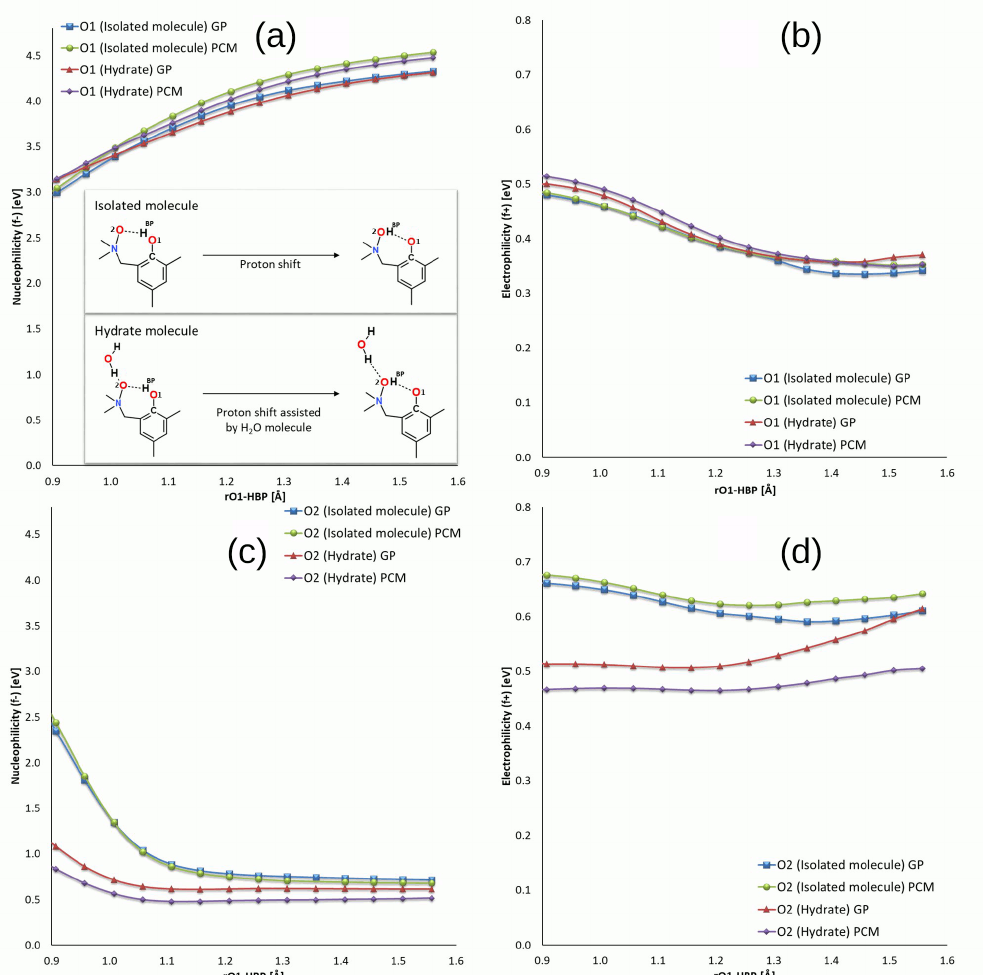
Figure 8. Calculated Fukui functions describing changes of nucleophilicity of O1 (top left, ( a )) and O2 (bottom left; ( c )) oxygen atoms and electrophilicity of O1 (top right, ( b )) and O2 (bottom right, ( d )) oxygen atoms along the proton HBP shift pathway. HBP—bridged proton, GP—gas phase, PCM—simulations with Polarizable Continuum Model and water as a